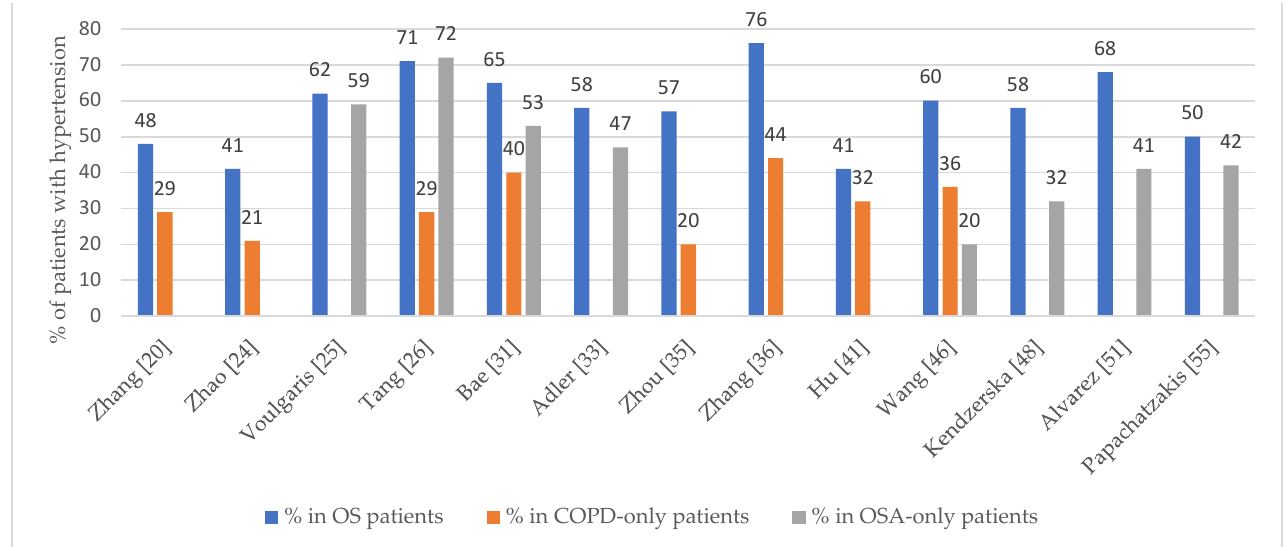
Figure 4. The prevalence of hypertension in OS, COPD-only, and OSA-only patients in the included studies [20,24–26,31,33,35,36,41,46,48,51,55]. Coronary heart disease (CHD), including myocardial infarction, was significantly more prevalent in OS patients than in COPD-only and OSA-only groups [20,24,26,31,33,39,46,48] (Figure S5).